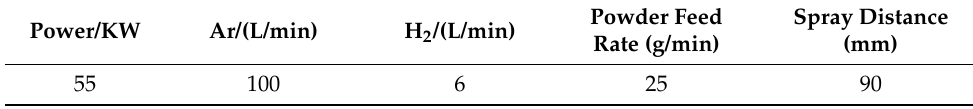
Table 2. The processing parameters of the